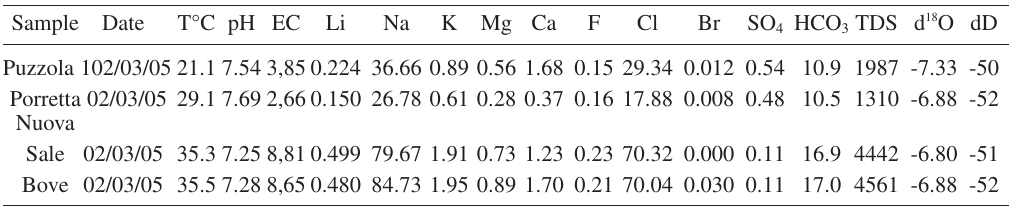
Table I. Chemical composition of the sampled thermal waters. Concentrations in meq/l; TDS in mg/l. EC = = electrical conductivity in mS/cm at 20°C. The isotopic composition of deuterium and oxygen are reported in δ unit per mil versus V-SMOW